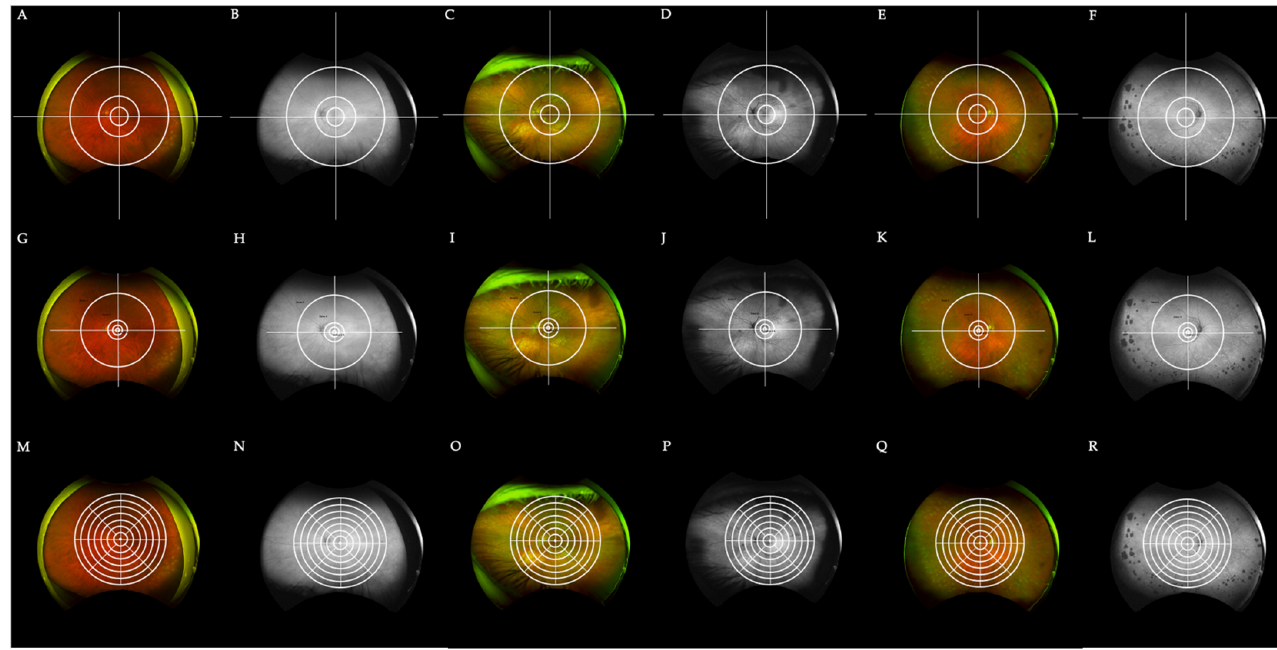
Figure 3. A comparison of the Boston grid to two other discussed grids for a total of 3 patients with AMD (A-F) .